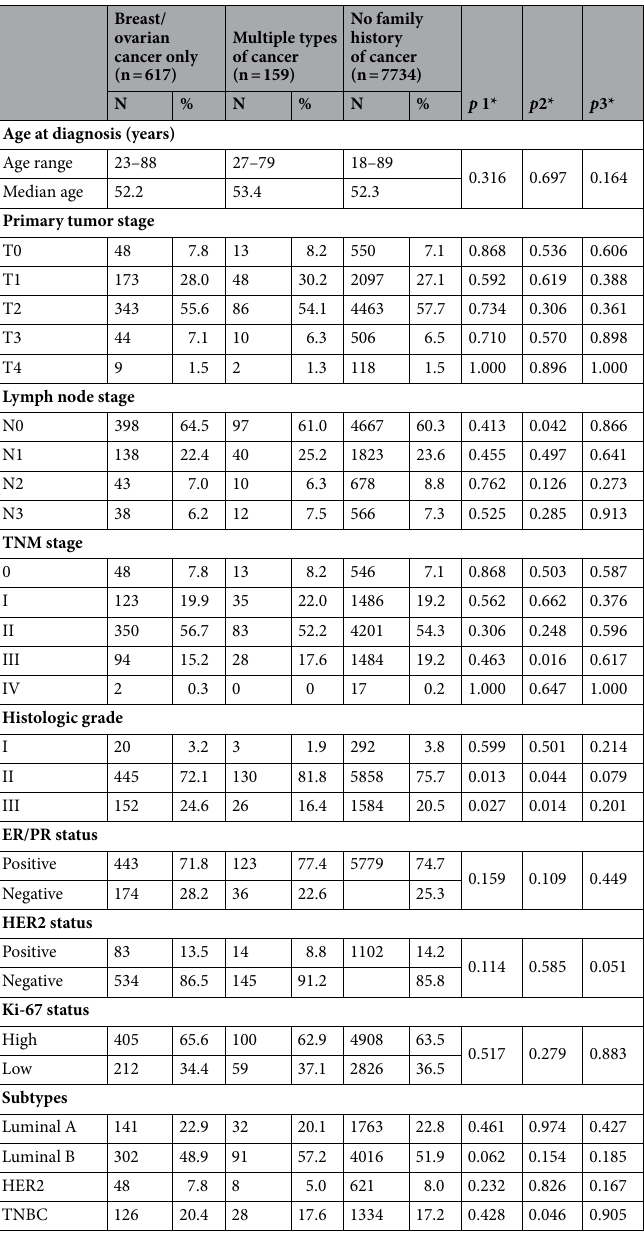
Table 5. Types of cancer in relatives and patients’ tumor characteristics. * p 1: single-FH vs. multiple-FH. p 2: single-FH vs. non-FH. p 3: multiple-FH vs.